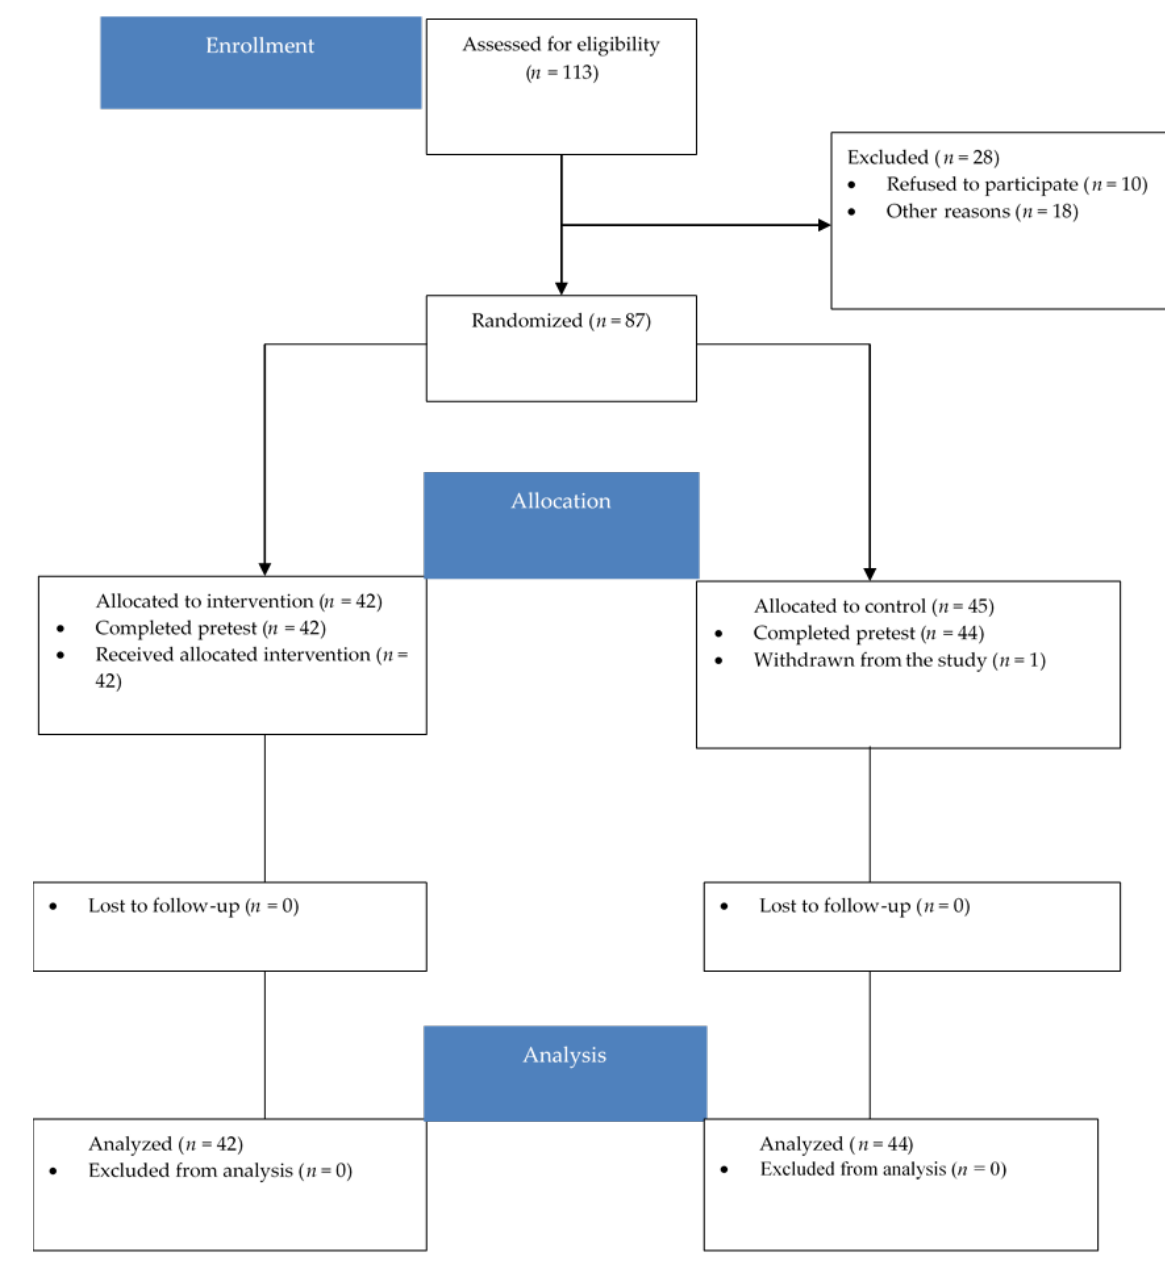
Figure 1. CONSORT Flow Diagram [26].